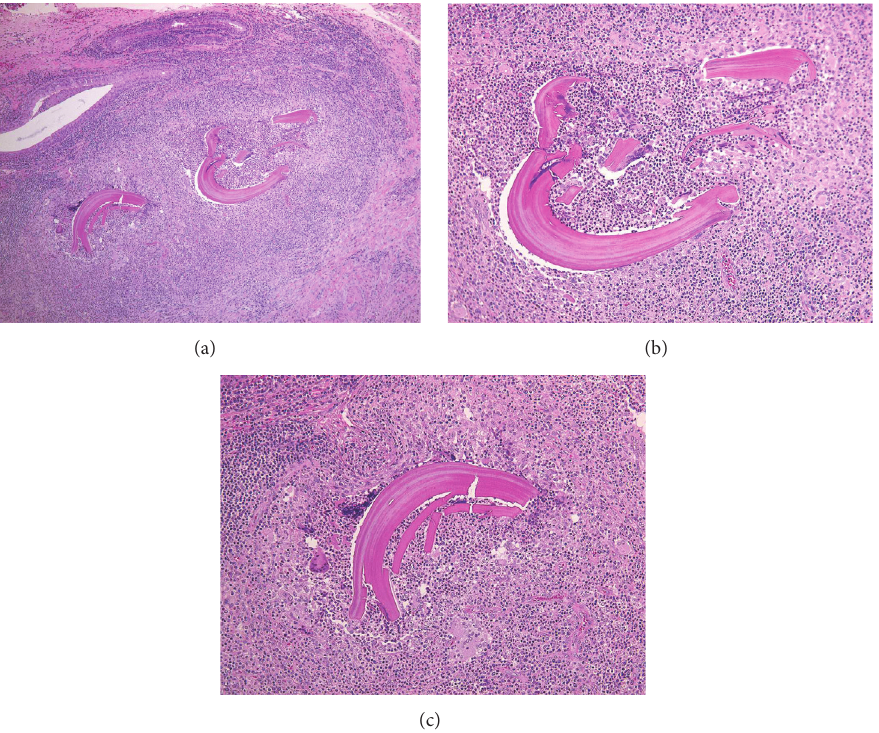
Figure 5: Histological findings (H&E staining). (a) Low-powered view of the lesion. (b, c) High-powered view of narrow, curved, eosinophilic